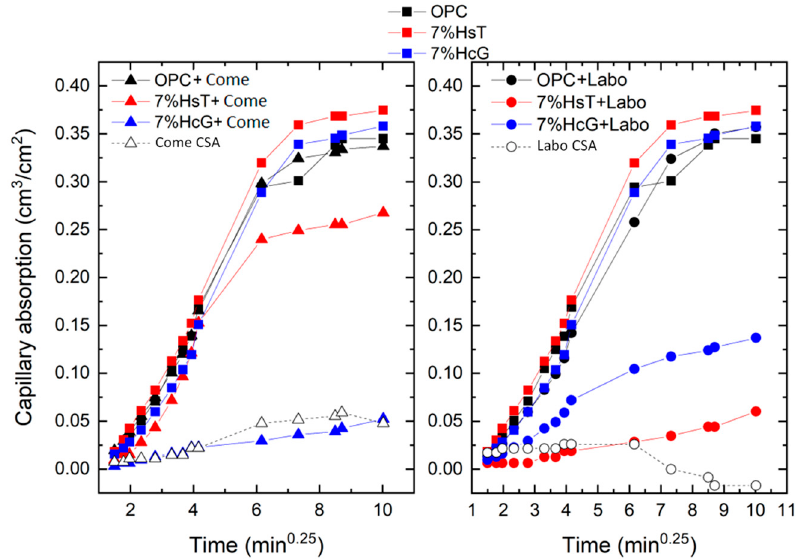
Figure 3. Capillary water absorption measurements for the mortars, employing the fourth root of the time [27].